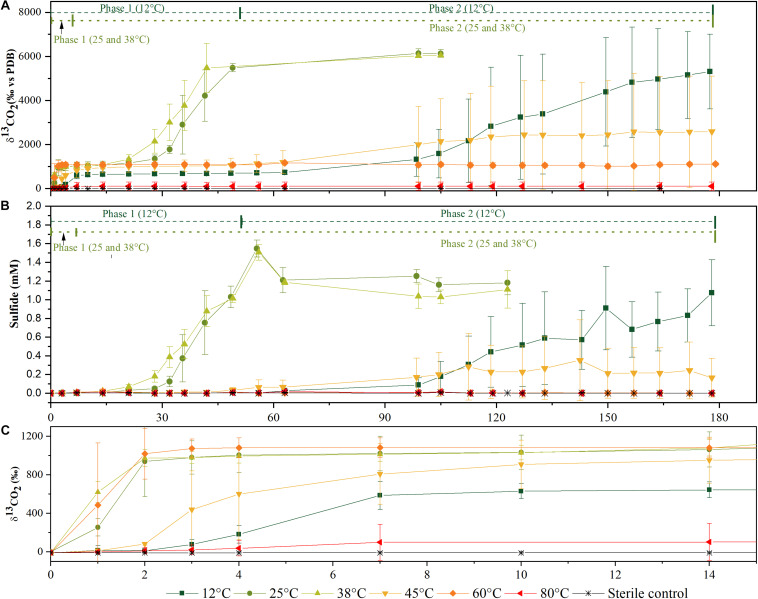
Time courses of 13C-labeled CO2 production (A) and of sulfide production (B) from microcosms incubated at different temperatures in the aerobic phase 1 and anaerobic phase 2 of mineralization. Zoom in of the time course during the first 15 days of (A,B) for 13C-labeled CO2 production (C) for higher resolution of mineralization phase 1. Data represented as an average of three biological replicates. Error bars represent ± standard deviations of the triplicate values.